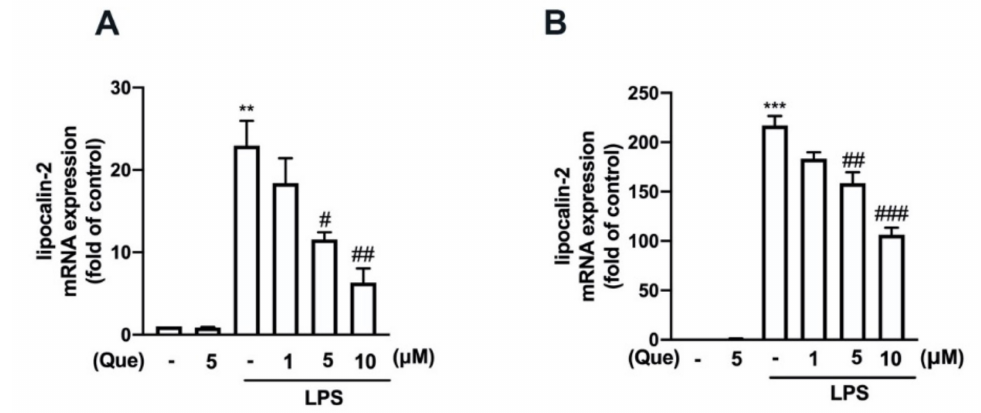
Figure 1. Inhibitory effects of quercetin on lipocalin-2 expression in macrophages and microglial cells. Mouse macrophage (RAW264.7) ( A ) and adult mouse microglial (IMG) ( B ) cells were stimulated with various concentrations of quercetin (1, 5, or 10 µ M) for 30 min followed by stimulation with lipopolysaccharides (LPS) (50 ng/mL) for another 6 h. The mRNA levels of of lipocalin-2 were analyzed by real-time polymerase chain reaction (PCR) and normalized to β -actin. Each bar represents the mean ± standard error of the mean (SEM) ( n = 3). Note: *** p < 0.005, ** p < 0.01 compared with the control group. ### p < 0.005, ## p < 0.01, # p < 0.05 compared with the LPS alone